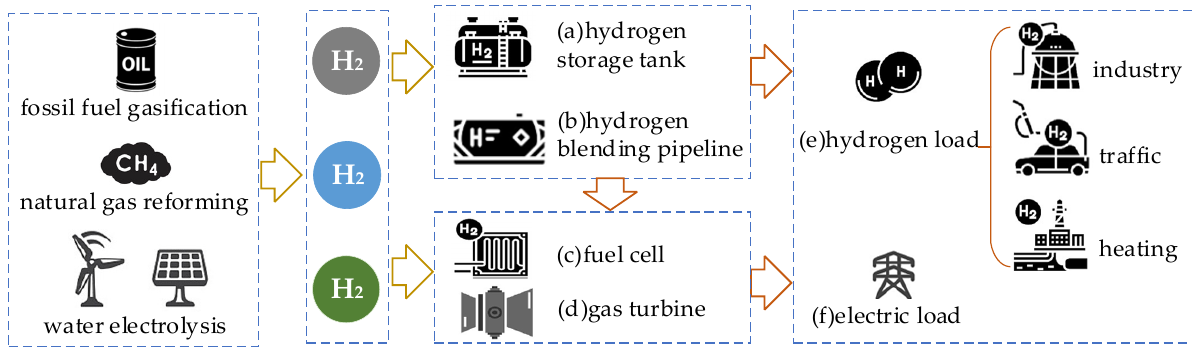
Figure 2. Comprehensive utilization of hydrogen energy.